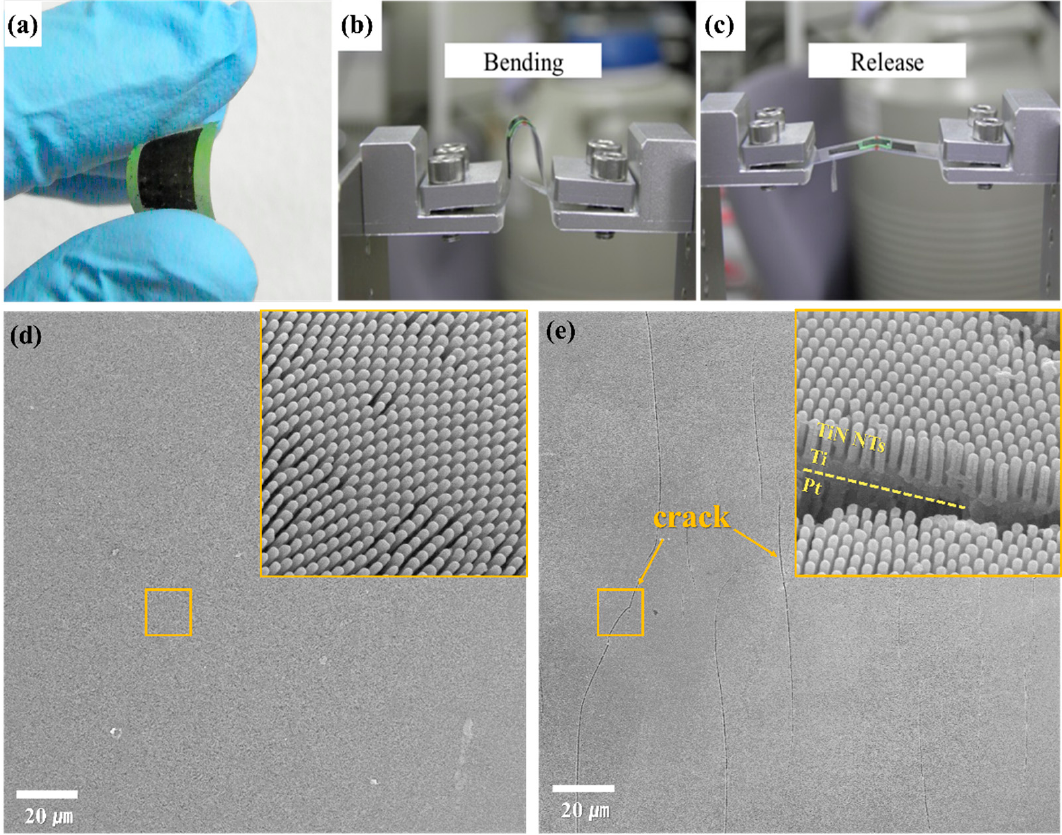
Figure 6. ( a ) Photograph of flexible TiN NT arrays. Cyclic bending ( b ) and releasing ( c ) tests of our array devices. SEM images of the TiN NT arrays upon cyclic bending tests after ( d ) 1000 and ( e ) 3000 cycles.